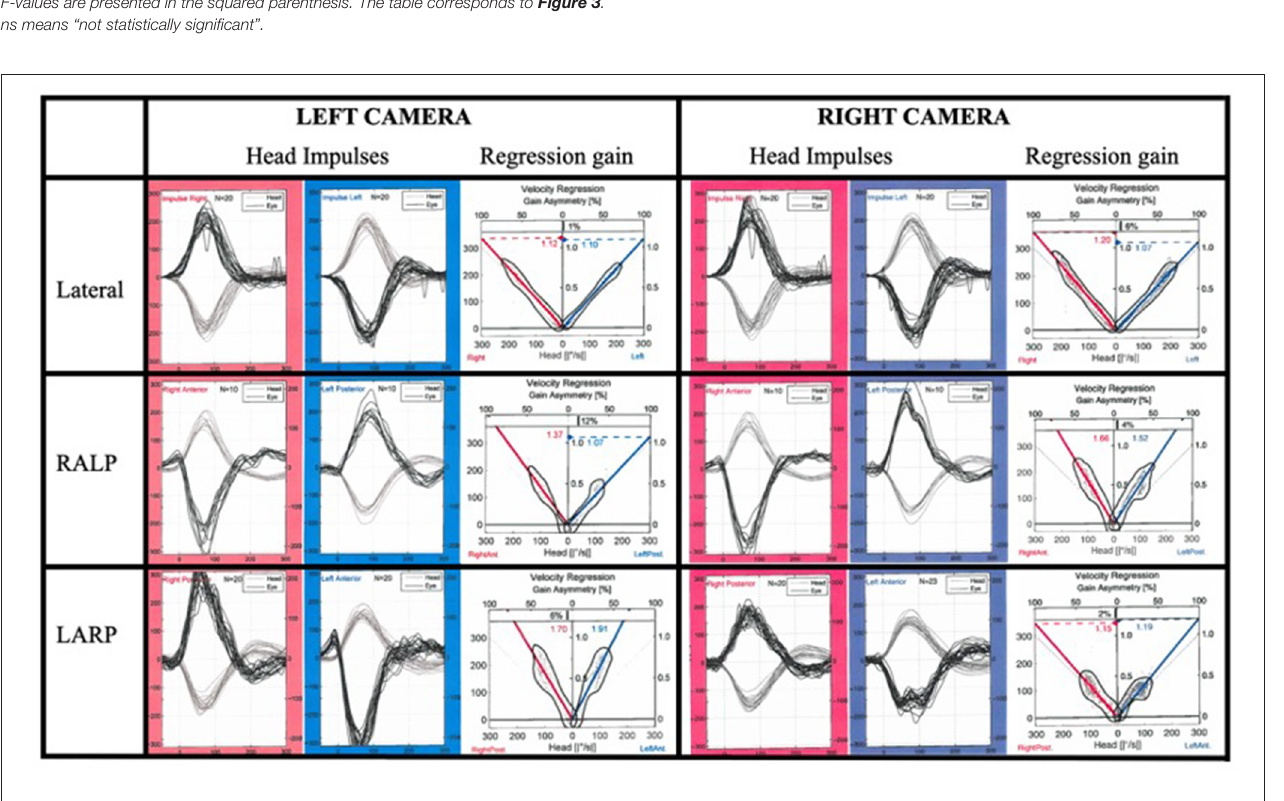
TABLE 3 | Repeated measures GLM ANOVA with main factors “stimulated side,” “semicircular canal,” and “recording device position” and their factor interactions. Stimulated side Semicircular Recording right/left canal device position right/left Lateral vs. Anterior